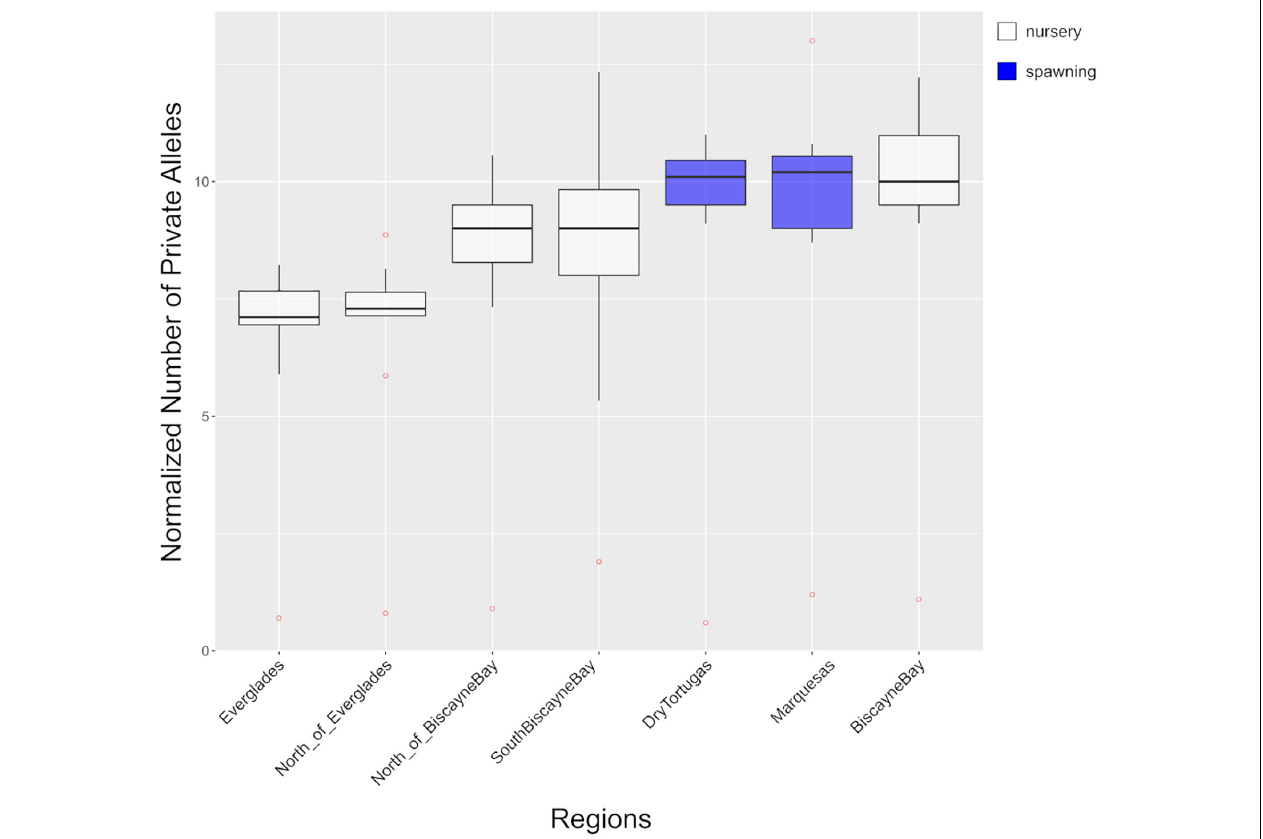
FIGURE 4 | The number of private alleles, normalized by each region’s sample size (referred to as PA norm in-text), are presented for each region. Detailed results for each dataset are presented in Supplementary Table 4 . Box color indicates the type of region: nursery region (white) or spawning region (blue). Outliers are red.